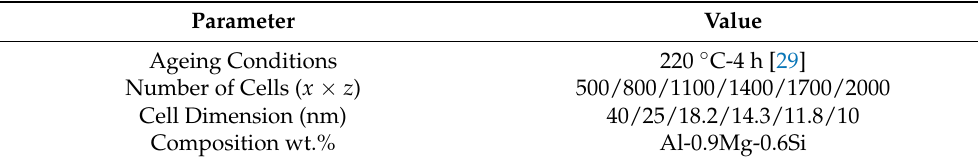
Table 3. Principal parameters of mesh analysis.